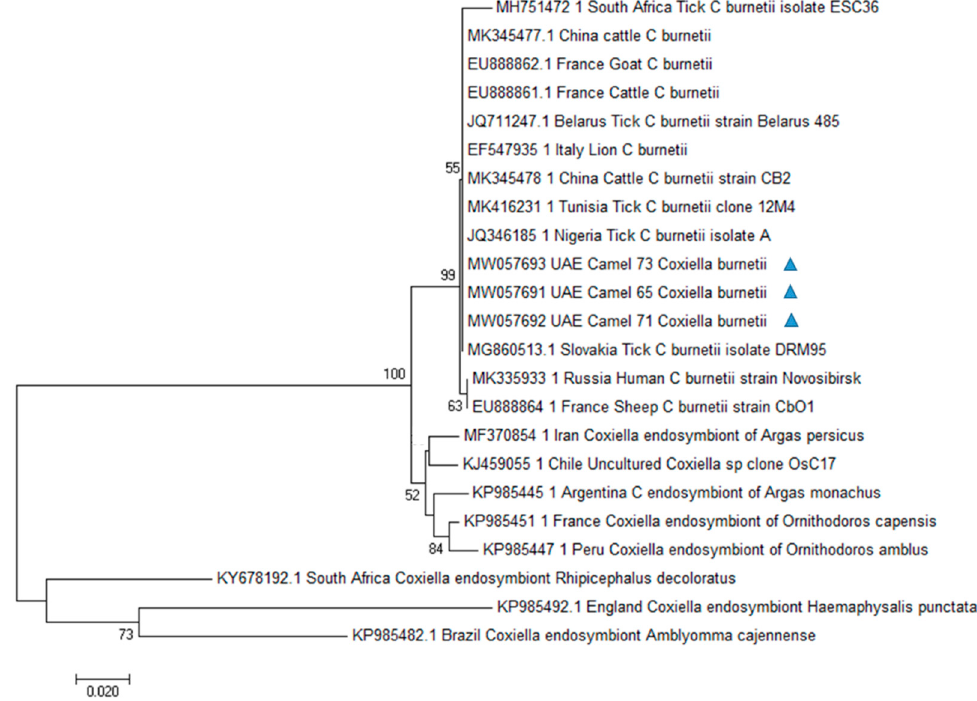
Figure 1. Phylogenetic analysis of Coxiella burnetii htpB gene sequences by Neighbor-Joining method based on the Kimura 2-parameter model. Evolutionary analyses were conducted in MEGA7. Numbers at nodes represent percentage occurrence in 1000 bootstrap replication. Sequences from this study are marked with triangle. The value lower than 50% are hidden.